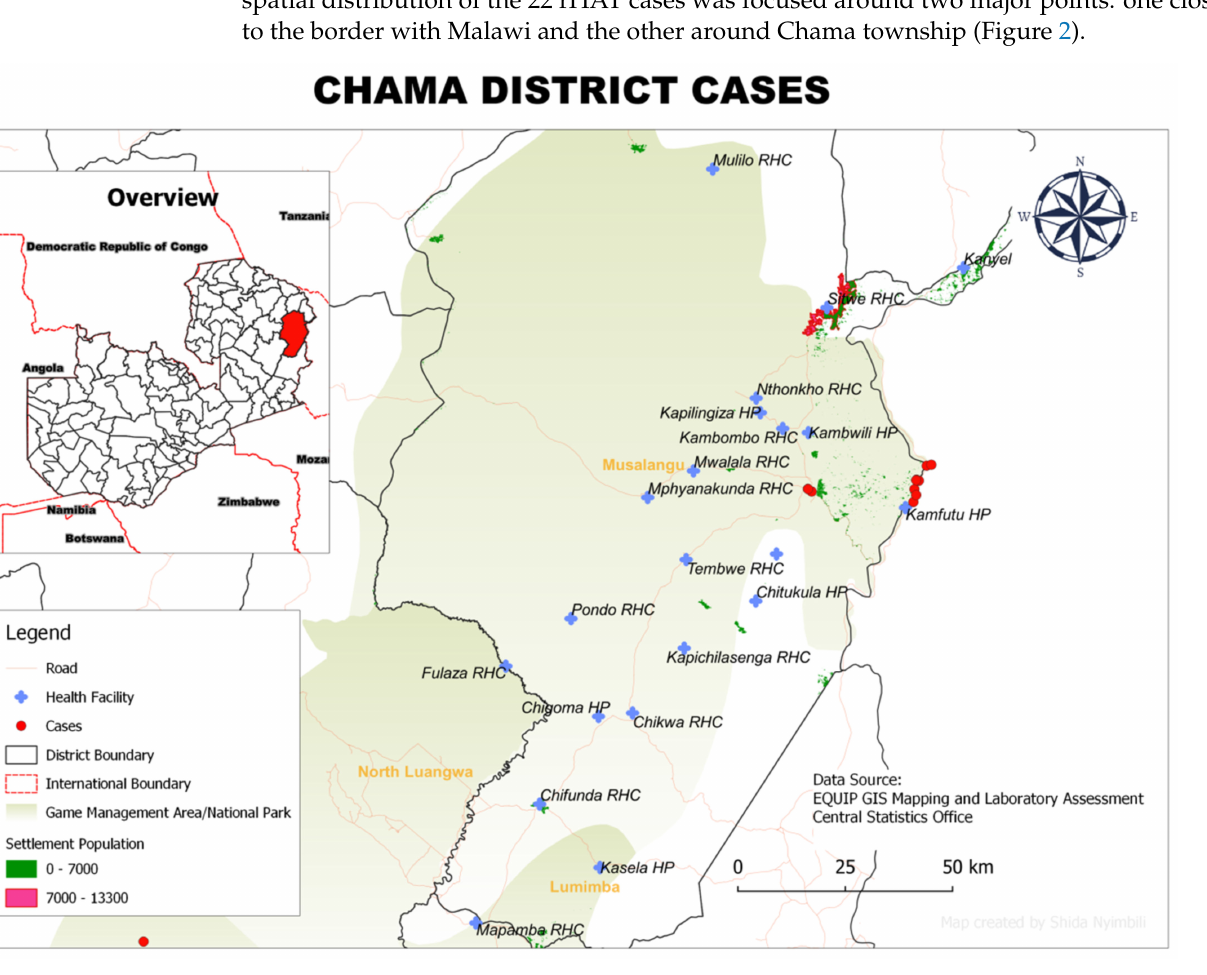
Figure 2. Spatial distribution of rHAT cases from 2004 to 2014 in Chama District, Muchinga Province,